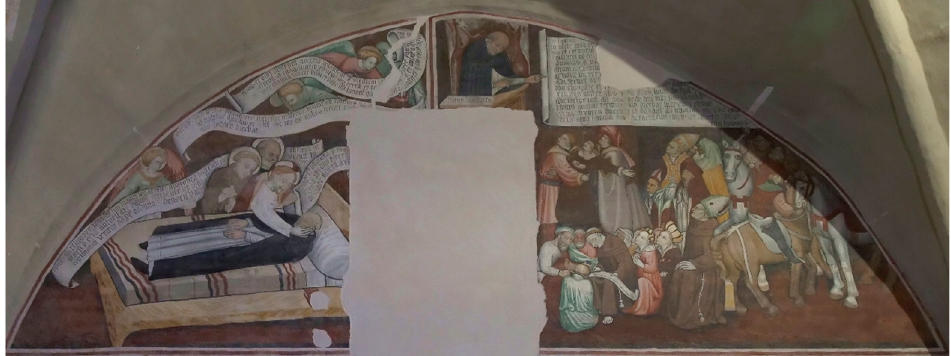
Figure 5. Vincent Ferrer’s vision and preaching. Santa Maria Assunta Parish Church (Macello, Piedmont). Aymo Duce, circa 1429 (photograph courtesy of Leonardo Guazzo).